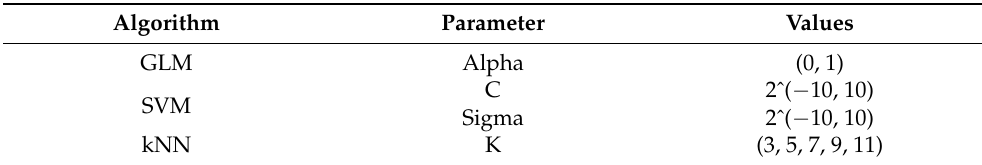
Table 3. Machine learning algorithms used, hyperparameters tuned, and values tested. Each algorithm represents a different family of algorithms.